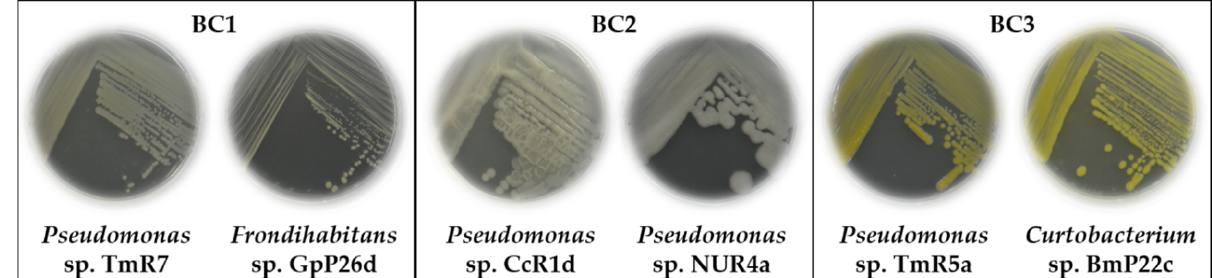
Figure 5. Selected bacterial consortia. The three bacterial consortia formulated with two bacteria are illustrated. Bacteria were grown in Tryptic Soy Agar (TSA) medium at room temperature. Abbreviation: BC, bacterial consortium. Table 5. Compatibility between selected bacterial strains. Table 6. Characteristics of the selected bacterial